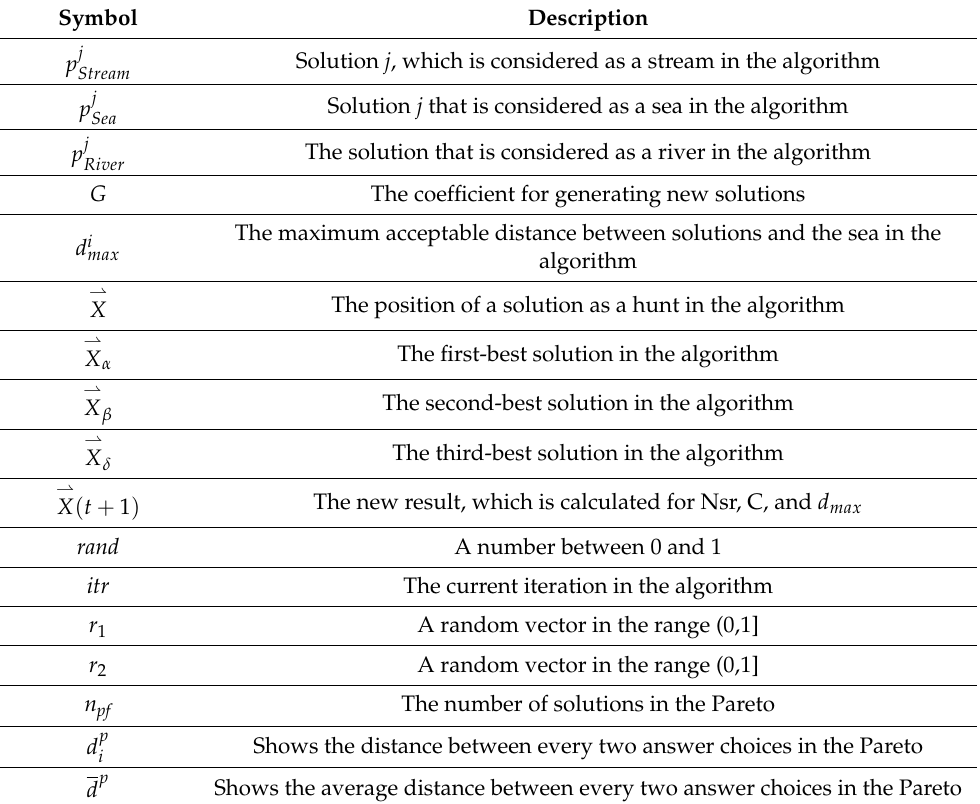
Table 3. Mathematical symbols of a proposed